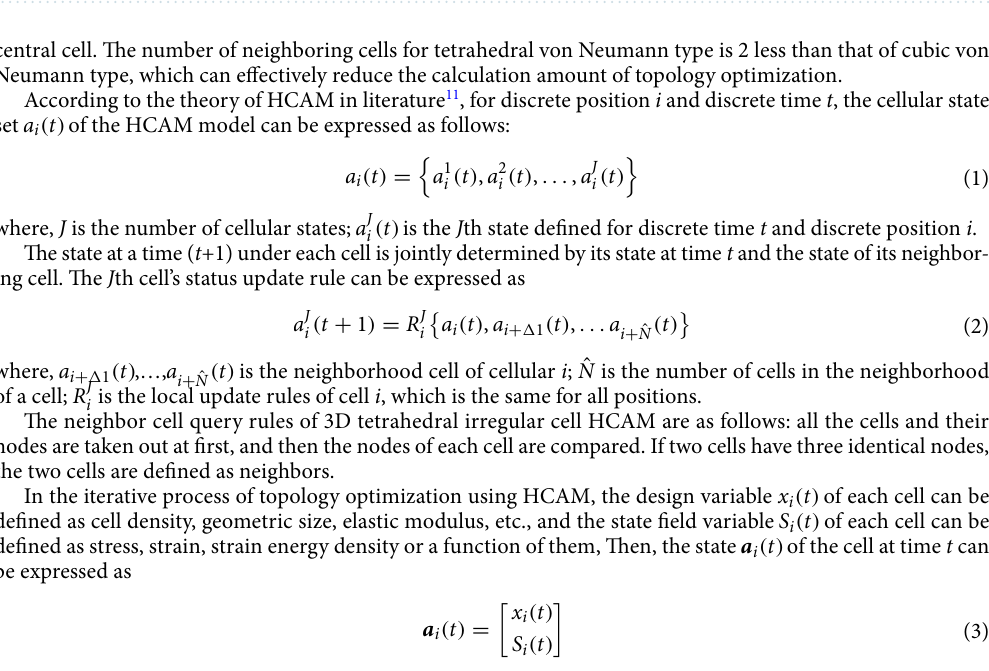
Figure 3. Neighborhoods of irregular cell in 3D tetrahedral von